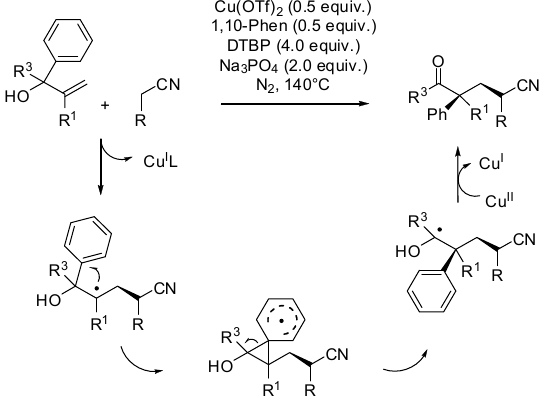
Scheme 8. Efficient synthesis of functionalized ketones containing an α -quaternary